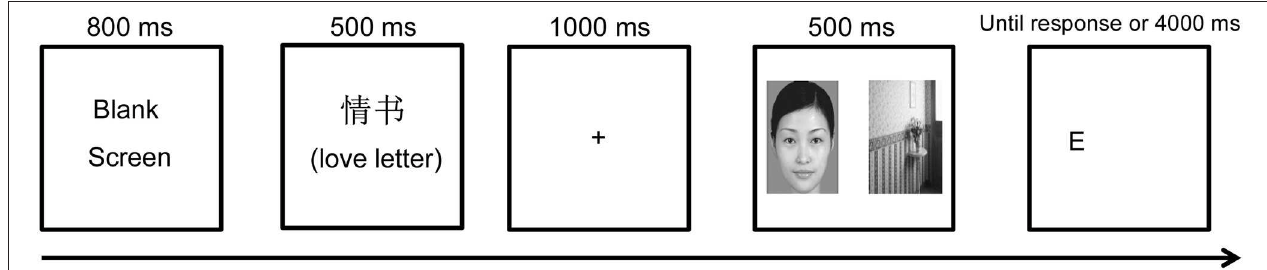
FIGURE 1 | Example of the dot probe task paradigm procedure (cited in Ma et al., 2015).